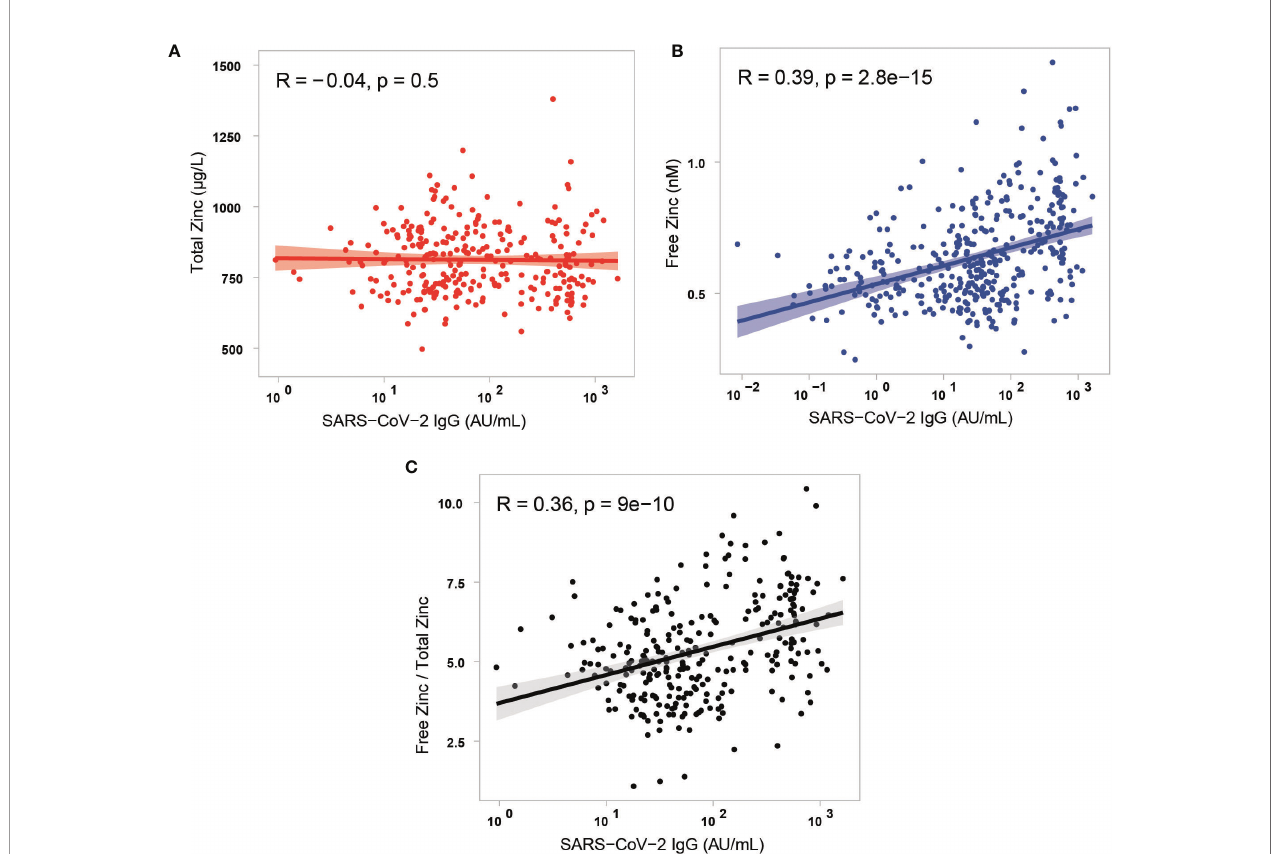
FIGURE 5 | Correlation analysis of the three different parameters of serum Zn status with antibodies to SARS-CoV-2. (A) Total serum Zn concentrations and antibodies to SARS-CoV-2 showed no signi fi cant correlation in the study cohort (three data points of very high serum Zn are not shown in the fi gure for reasons of scale). The parameters (B) free Zn concentrations, and (C) free Zn/total Zn ratio correlated positively and signi fi cantly with antibodies to SARS-CoV-2. Data were analysed by Spearman ’ s rank